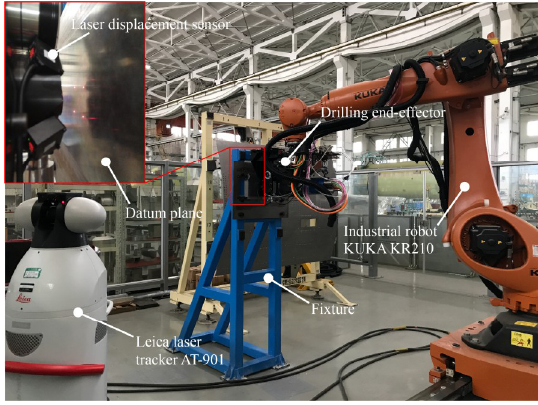
Figure 9. The experimental setup of the robotic drilling system.